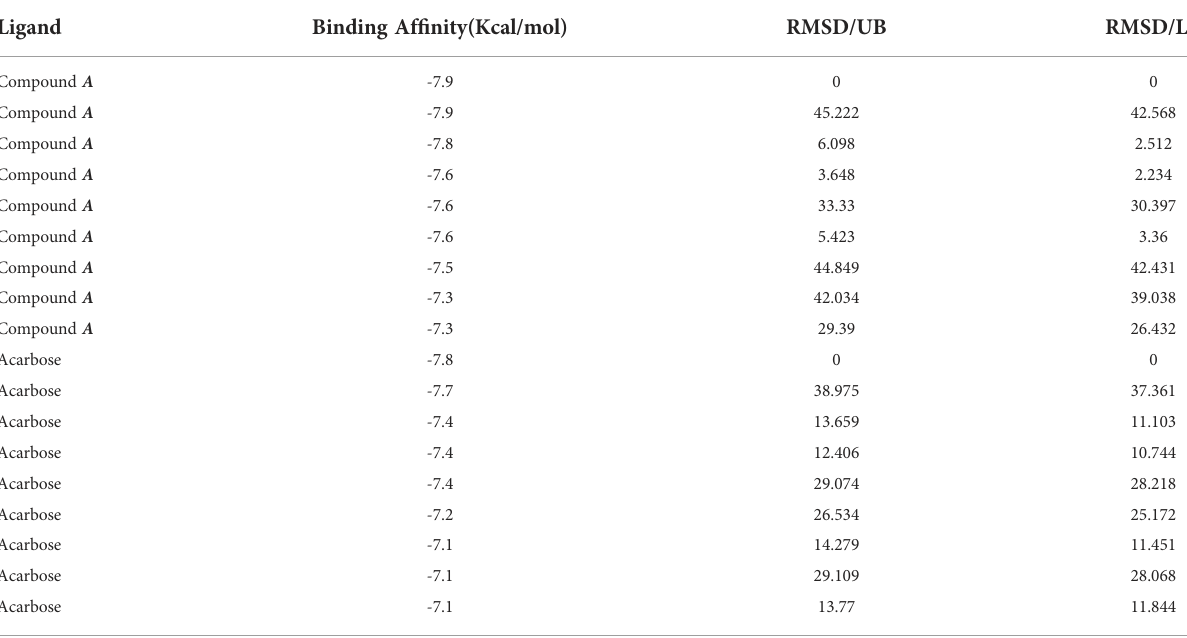
TABLE 2 Calculations of binding af fi nity values of